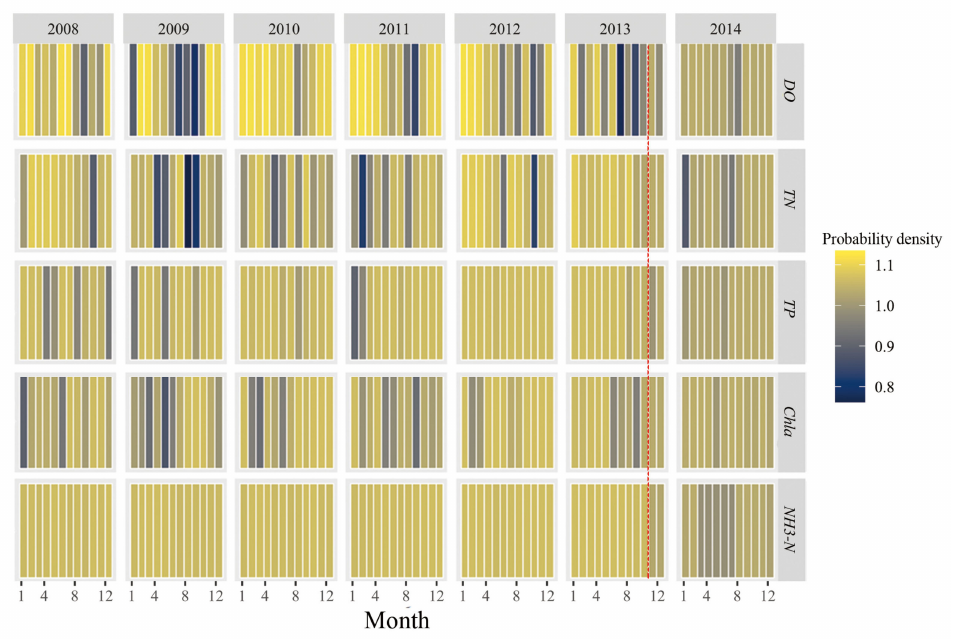
Figure 8. Time-series graph of risk probability density change for the full sample period. Taking the red line as the demarcation line, the model was divided into two periods—before (January 2008–October 2013, the left of the red line) and after (November 2013–December 2014, the right of the red line) the operation of the IRSN. The probability density is used to specify the probability of the random variable falling within a particular range of values. Through our calculation of the risk probability density for full sample period, the probability density of water quality indicators ranges from 0.76 to